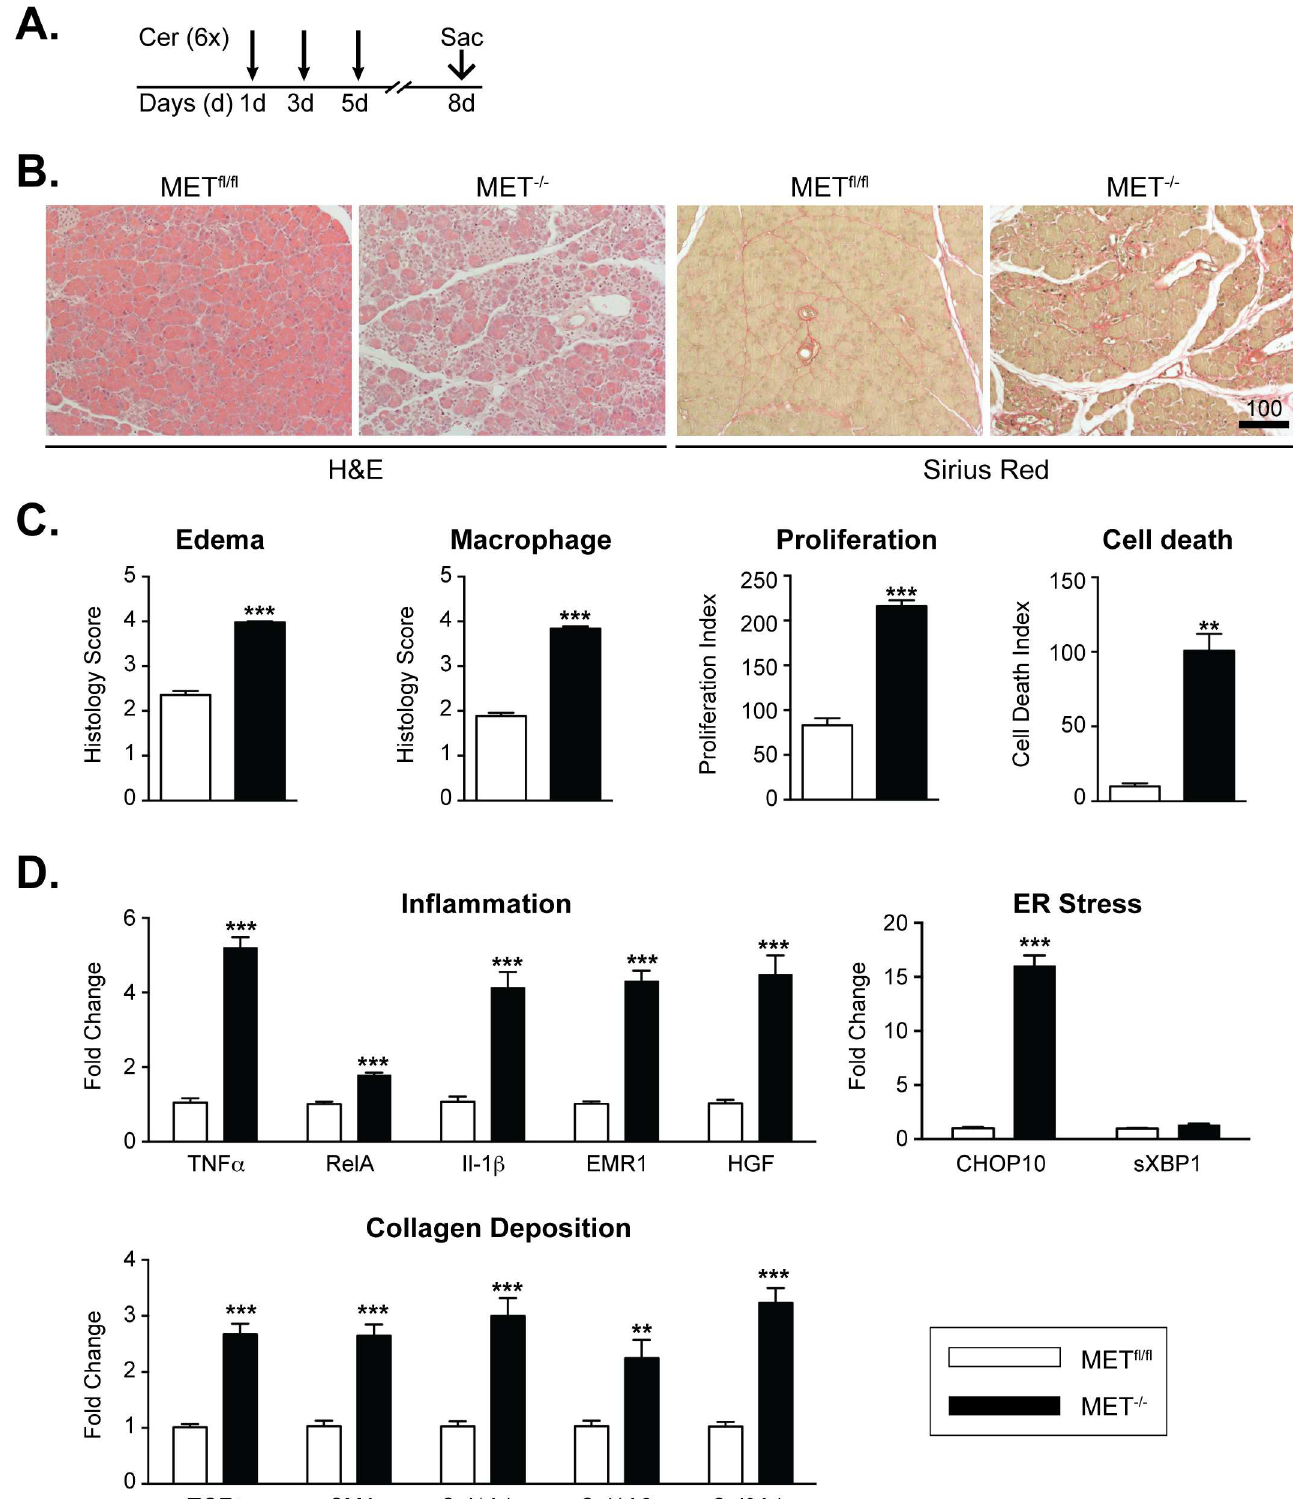
Fig 5. MET is critical for acinar regeneration following recurrent cerulein induced injury. A, MET fl/fl and MET -/- mice were injected with six, hourly-spaced intraperitoneal injections of cerulein, on alternate days for three days and allowedto recover for 72 h. B, Pancreatic sections were